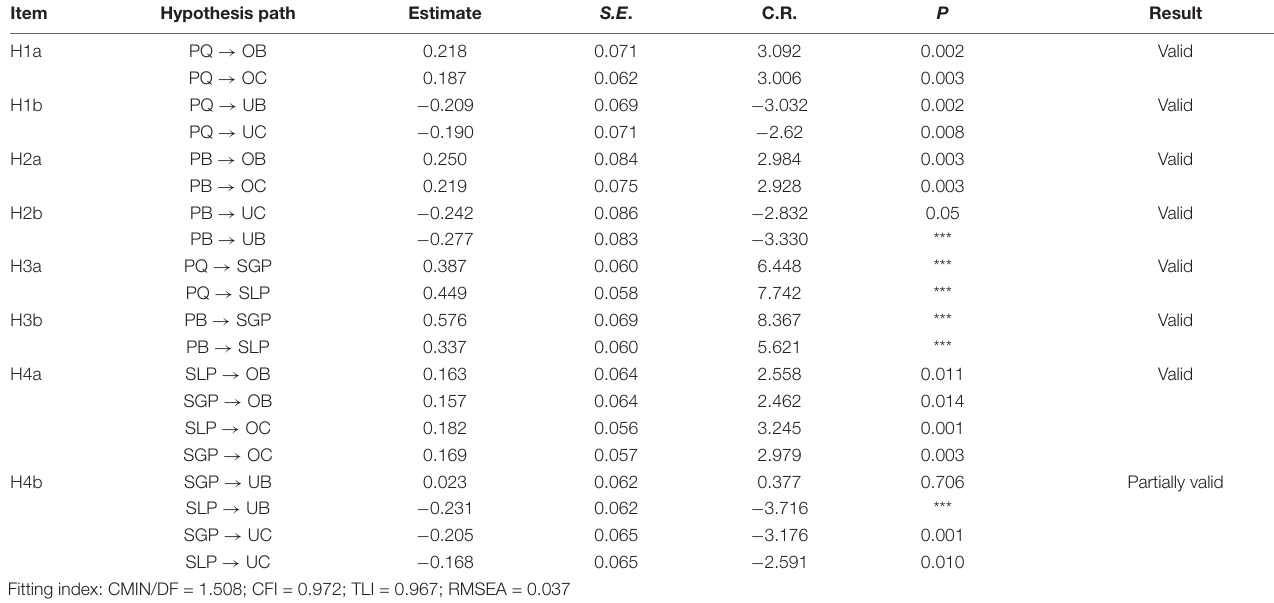
TABLE 3 | Path check of hypothesis. Item Hypothesis path